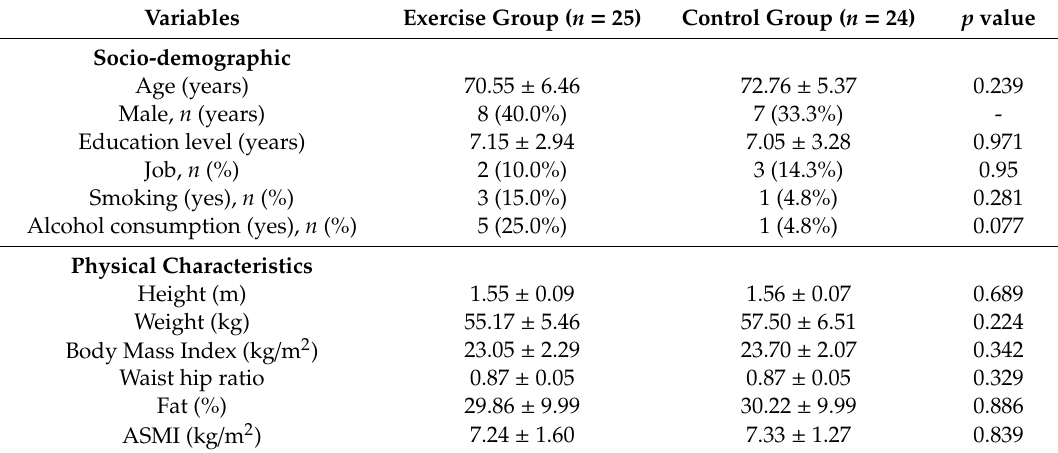
Table 2. Baseline characteristics of socio-demographic, physical characteristics, daily physical activity, mental and cognitive